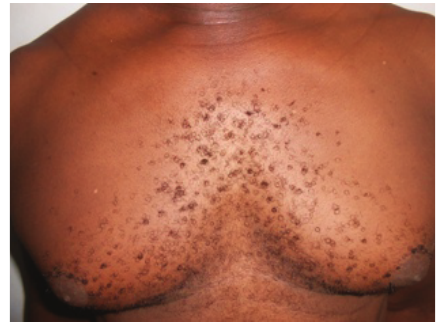
Figure 2: Complete cure of the patient after two weeks.